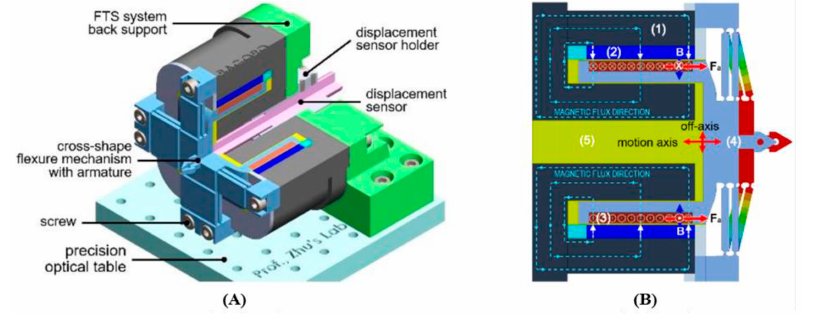
Figure 10. Electromagnetically actuated CM-based FTS [78]. ( A ) CM components of FTSs are displayed; ( B ) Electromagnetic actuator components are shown where (1) stator, (2) permanent magnet, (3) coil, (4) moving stage and (5) air